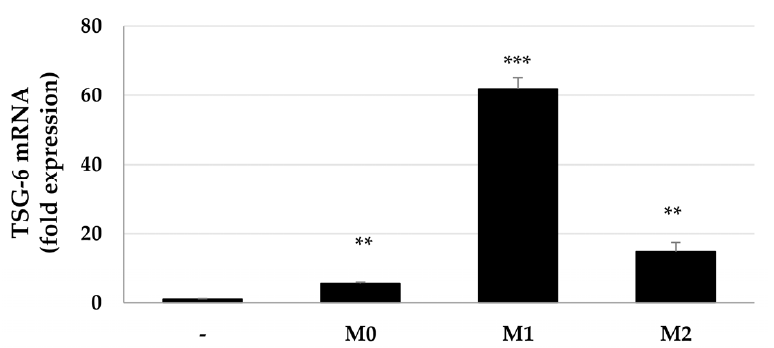
Figure 1. TSG-6 mRNA expression in ASCs indirectly cocultured with macrophages. ASCs were indirectly cocultured with macrophages for 2 days and TSG-6 mRNA expression assessed by qPCR. All qPCR reactions were performed in triplicate. GAPDH expression was used for normalization. The 2 − ( ∆∆ Ct) method was used to calculate relative fold changes in mRNA expression. Data are presented as the mean ± standard deviation (SD) of three independent experiments. ** p ≤ 0.01 and *** p < 0.001. M0, macrophages differentiated from THP-1 monocytes; M1, M0 macrophages treated with IFN- γ and LPS; M2, M0 macrophages treated with IL-4 and